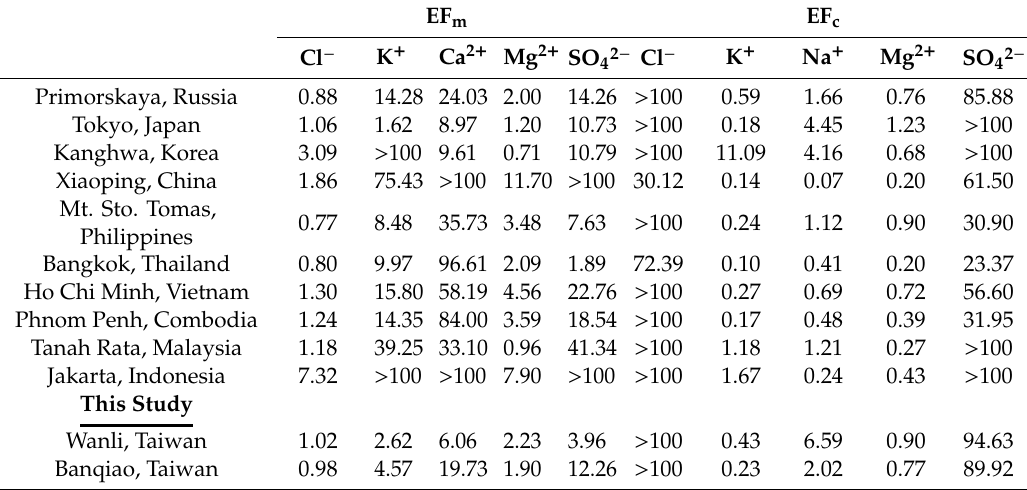
Table 2. Enrichment factors for sea salt and crust components relative for